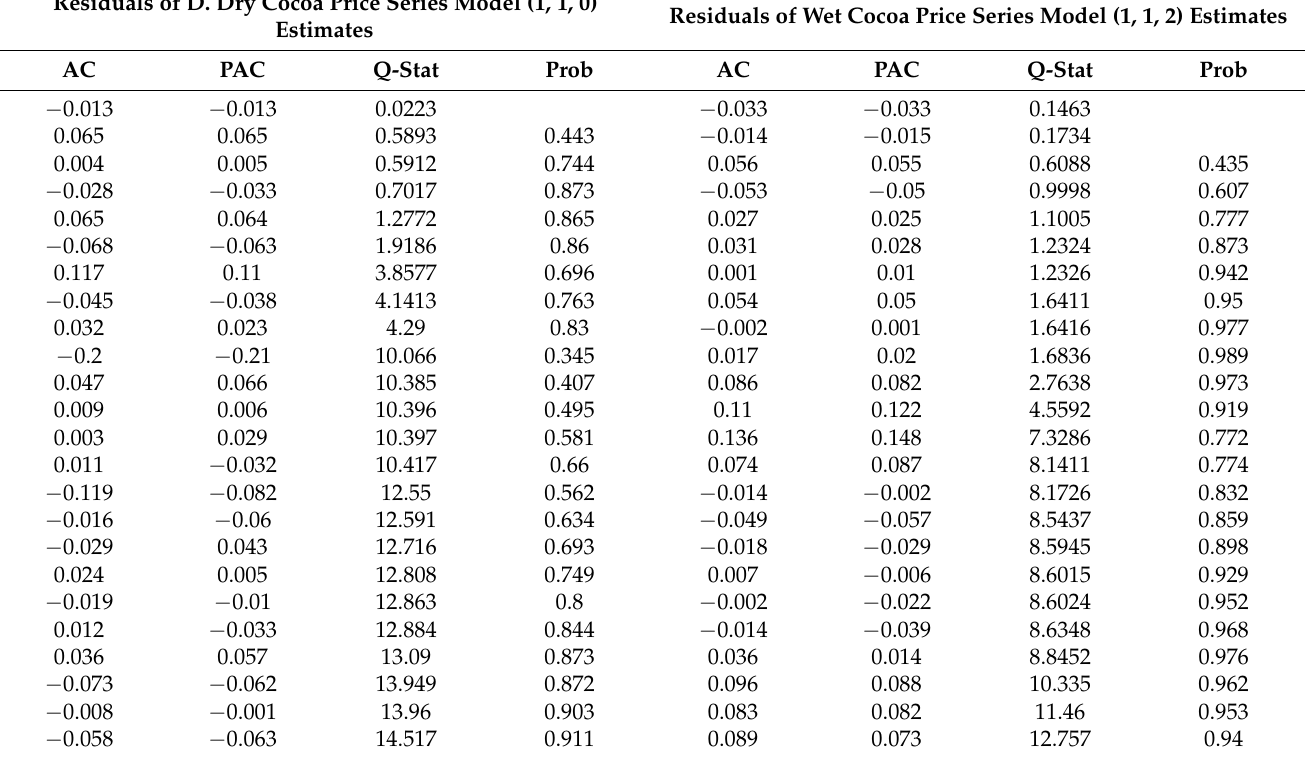
Table 7. Auto correlation and Partial autocorrelation values for residuals of models(1, 1, 0) and (1, 1, 2).